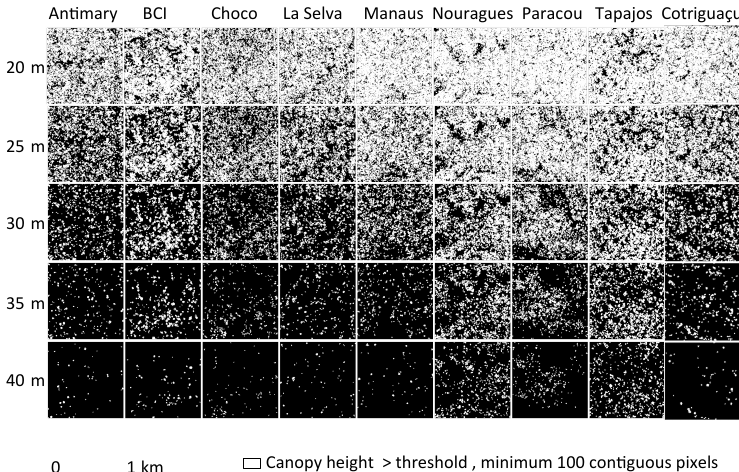
Figure 1. Segmentation of the 1km × 1km images in each site using five canopy height thresholds. A minimum of 100 contiguous pixels was used as a segmentation threshold in all cases.